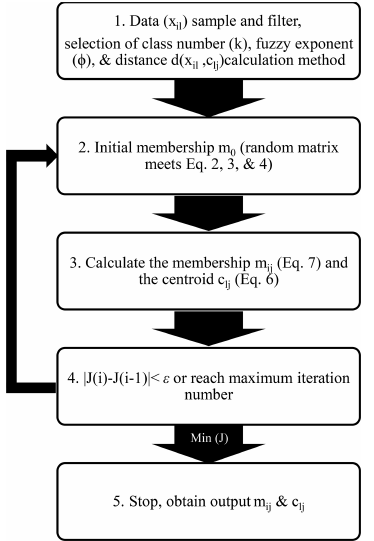
Figure 1. Flowchart illustrating the operation of the fuzzy k -means